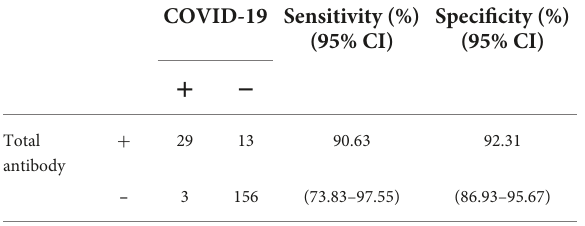
TABLE 3 Diagnostic efficacy of the total antibody titer in unspecific reactivity and COVID-19 according to the cut-off of 13.87 cut-off index (COI).